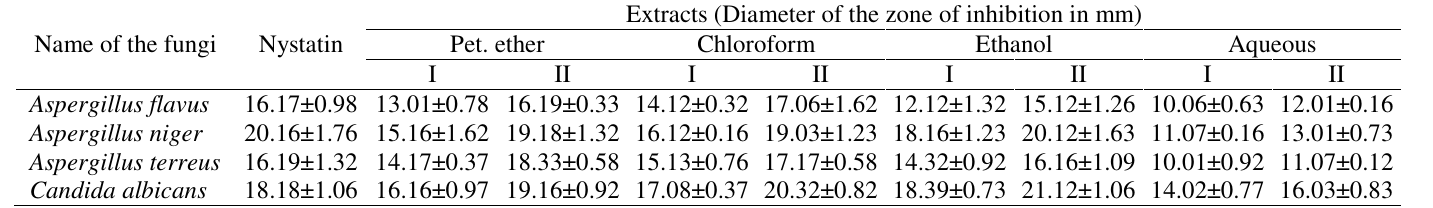
Table 4. Antifungal activity of Digera muricata (L.) Mart. extracts on